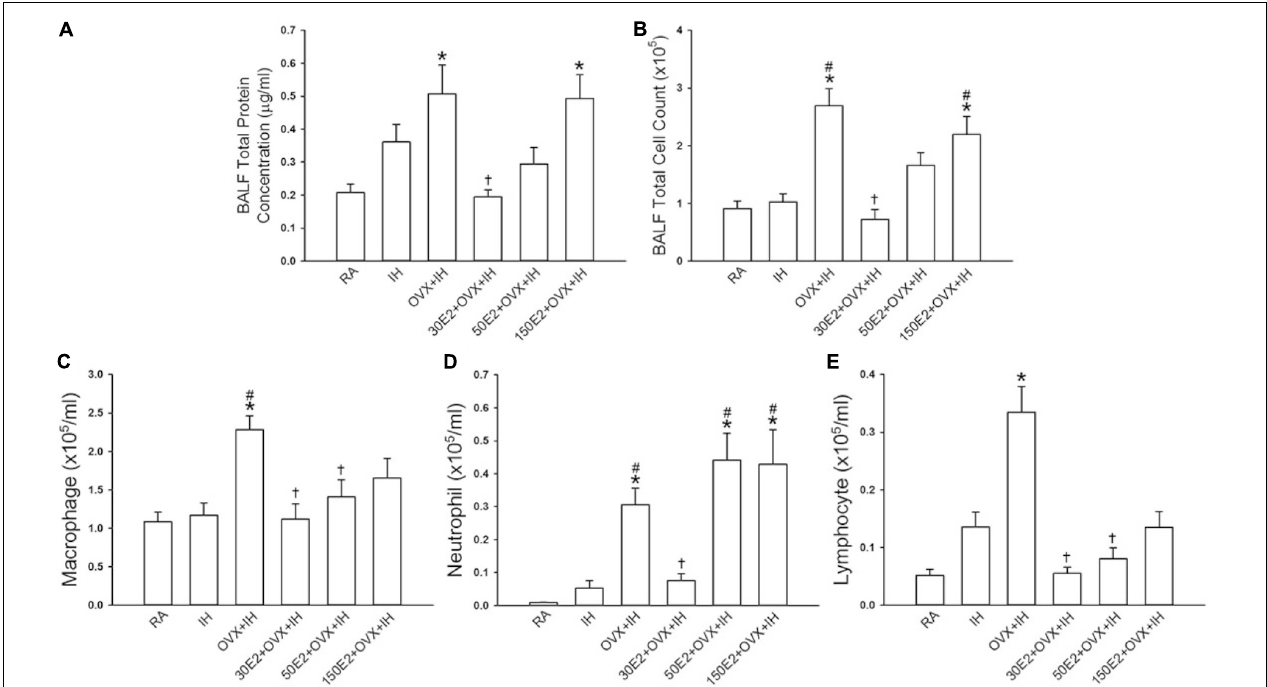
FIGURE 6 | Changes in total cell count and differential cell counts in bronchoalveolar lavage fluid (BALF) from female rats. Two groups of intact rats were exposed to RA or IH for 14 days. The four other groups consisted of OVX rats alone (OVX + IH) or under supplementation with three different concentrations of E2: 30, 50, and 150 µ g/ml (30E2 + OVX + IH, 50E2 + OVX + IH, 150E2 + OVX + IH) and exposed to IH for 14 days. The indices measured were total protein concentration (A) , total cell count (B) , and differential cell count: macrophage (C) , neutrophil (D) , and lymphocyte (E) in BALF sampled from rats of the six study groups. ∗ p < 0.05 compared with responses of RA rats; # p < 0.05 compared with responses of IH rats; † p < 0.05 compared with OVX + IH rats. Data in each group are presented as means ± SE of five